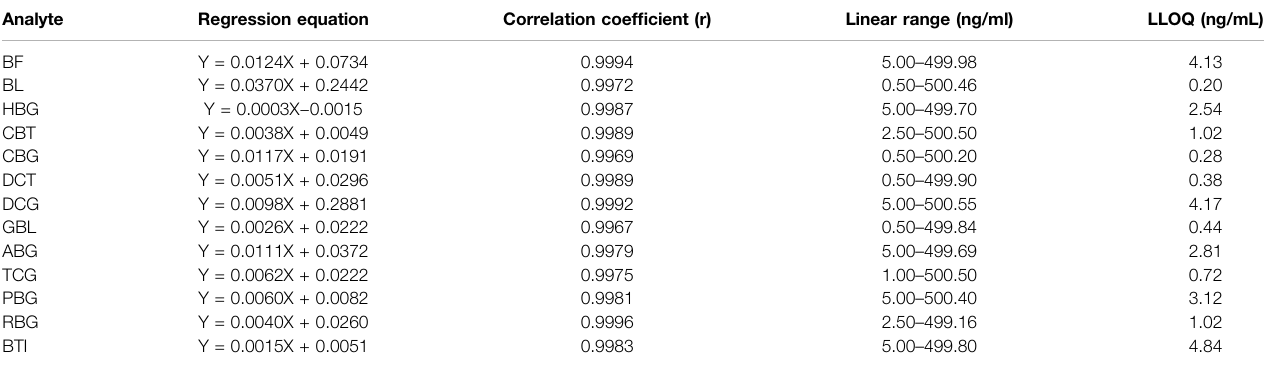
TABLE 2 | Regression equations, linear range, and lower limit of quanti fi cation (LLOQ) of analytes in the rat plasma.